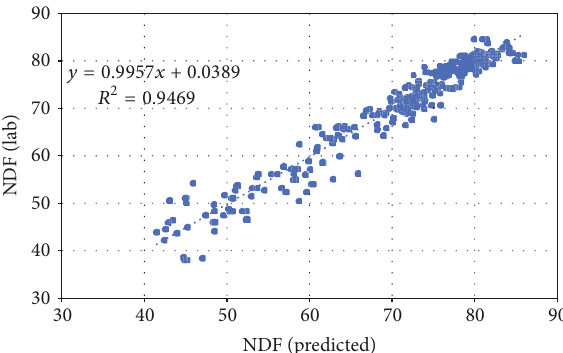
Figure 2: Linear regression relationship between laboratory refer- ence methods and NIRS-predicted values for ADF ( 𝑅 2 = 0.96 ) of winter and spring canola from 2011 on a dry weight basis.